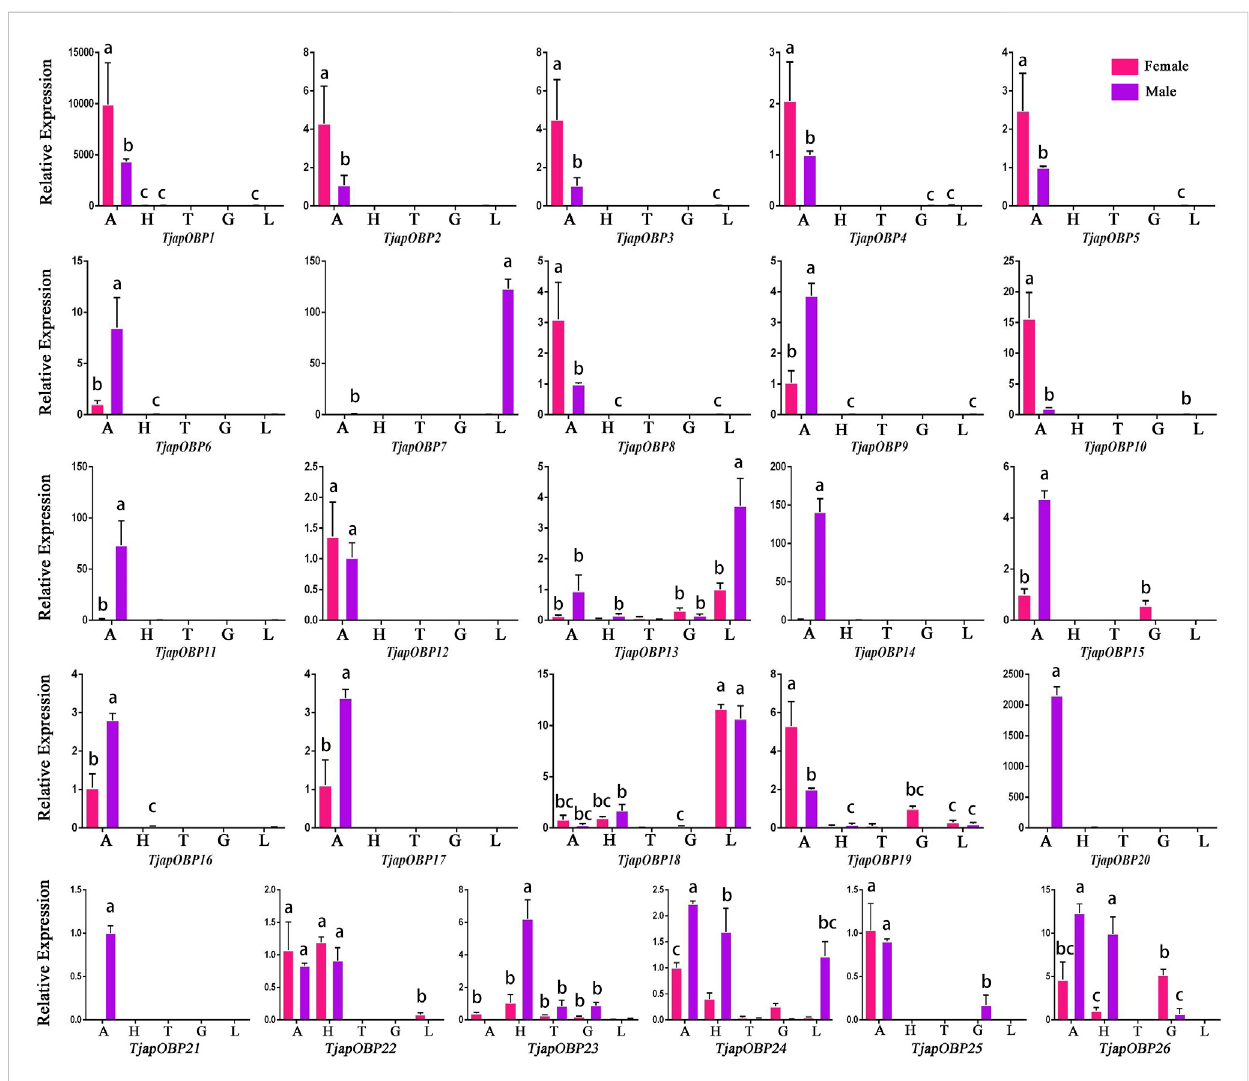
FIGURE 8 Expression pro fi les of T. japonensis OBPs in different tissues of female and male. A, antennae; H, heads (without antennae); T, thoraxes; G, external genitals; L, legs. The letters above the error bar denote signi fi cant differences ( p <